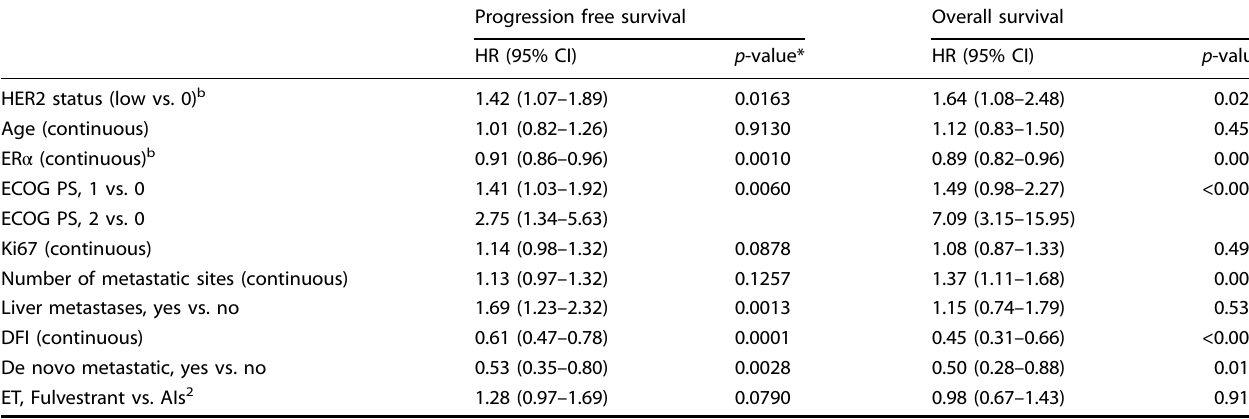
Table 1. Cox proportional hazards multivariable models for progression free survival and overall